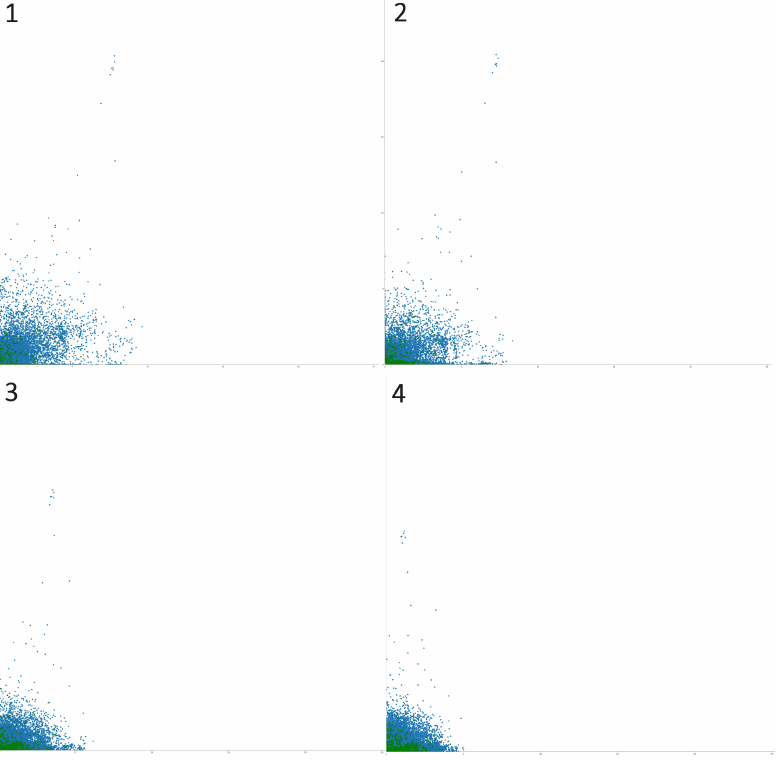
Figure 5. The examples of clustering using the barycenter-based minimization method obtained on four consequent encoder forward passes. Green color points are the ID s, blue color points are the UD